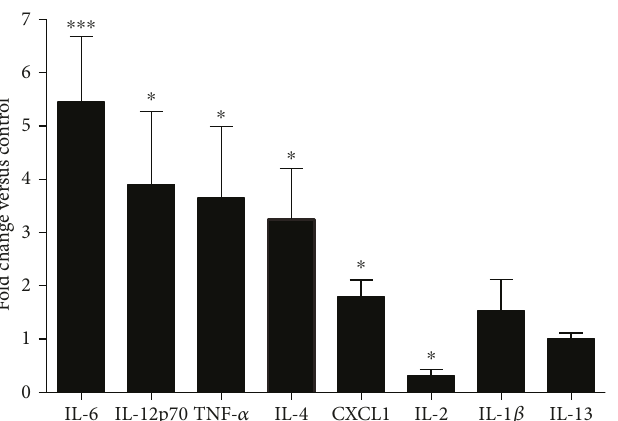
Figure 1: Cytokine levels in the plasma of the KO mice ( n = 9 ) compared to the controls ( n = 9 ). The data represent the average fold modi fi cation ± SEM versus the controls, as determined by the xMAP multiplex assay; molecules have been arranged in order of statistical signi fi cance. ∗ p < 0 05 and ∗∗∗ p < 0 001 indicate statistical signi fi cance compared with the